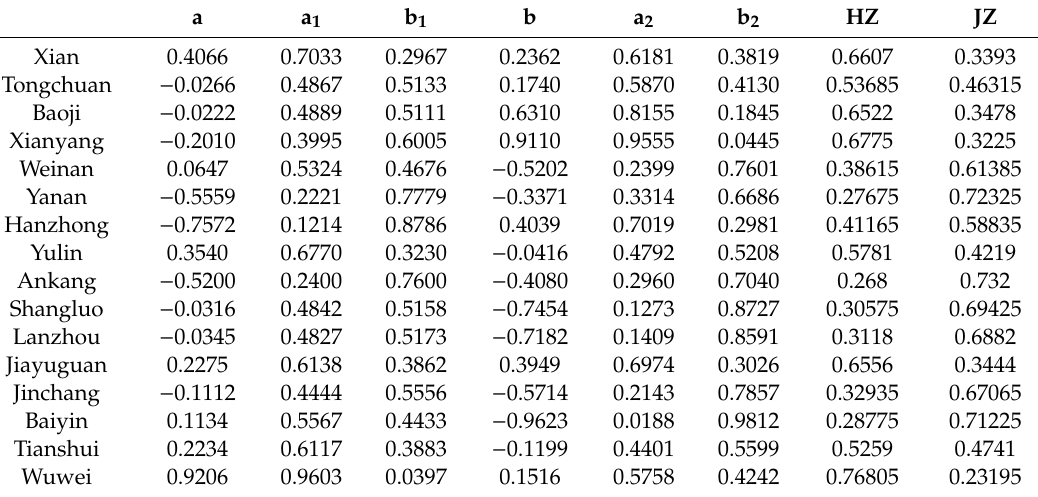
Table A14. The synergetic parameters of urban-rural water poverty in northwest